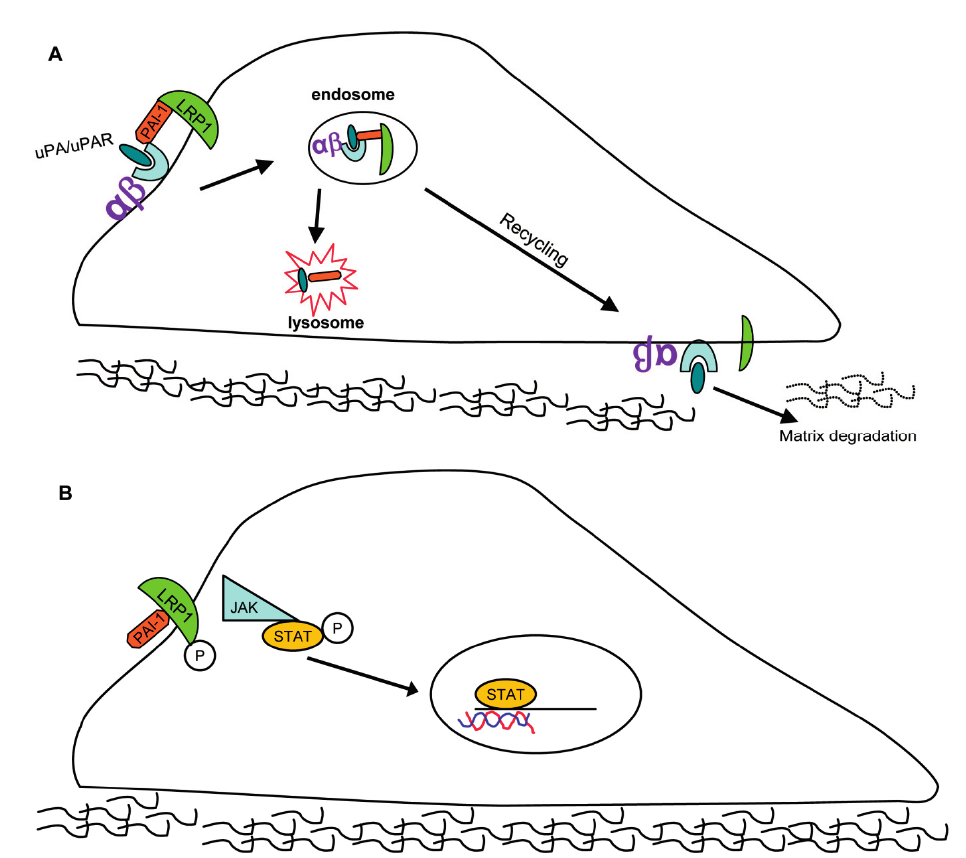
Figure 3. PAI-1 contributes to wound repair by affecting cell migration: Two possible pathways. ( A ) Pathway 1: PAI-1/uPA/uPAR (uPA receptor)/LRP1/integrin complexes are endocytosed with subsequent uPAR/LRP1/integrin redistribution to the leading edge, causing an “adhesion-detachment-readhesion” cycle that promotes cell migration. ( B ) Pathway 2: PAI-1 binds to LRP1 in a uPA/uPAR-independent manner triggering JAK/STAT1 pathway activation resulting in stimulation of cell